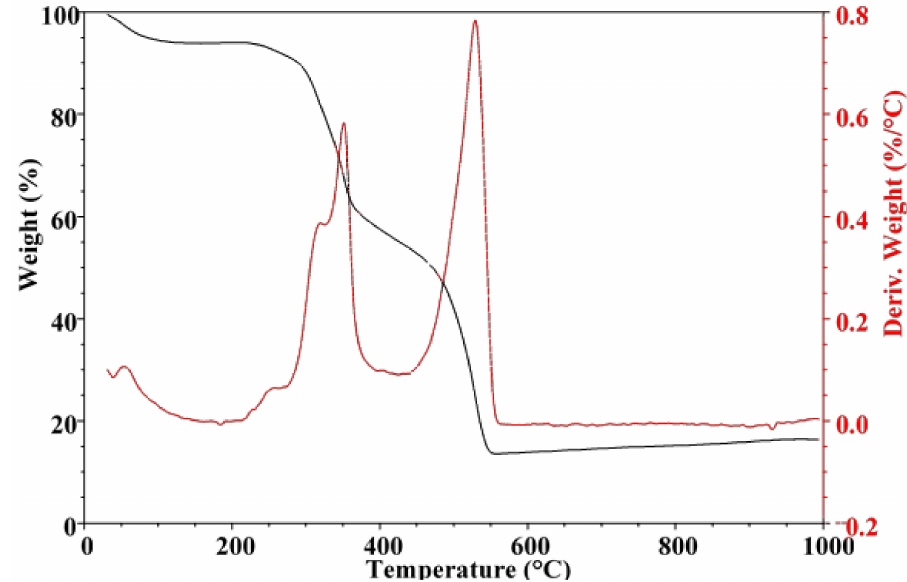
Figure 11. Thermogravimetric (TG) and derivative TG curves of degummed silk fibroin (SF).